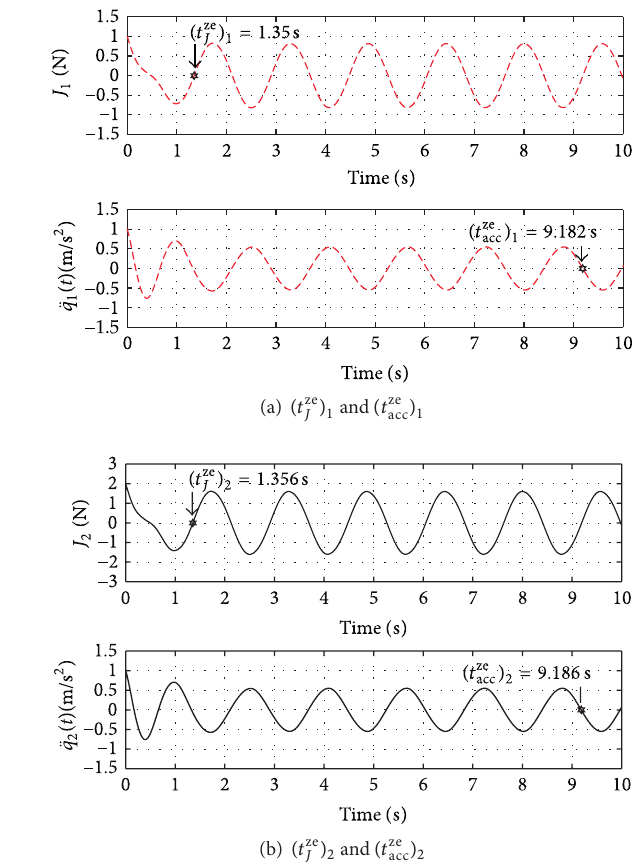
Figure 4: Illustration of zero-crossing times from the transient region.